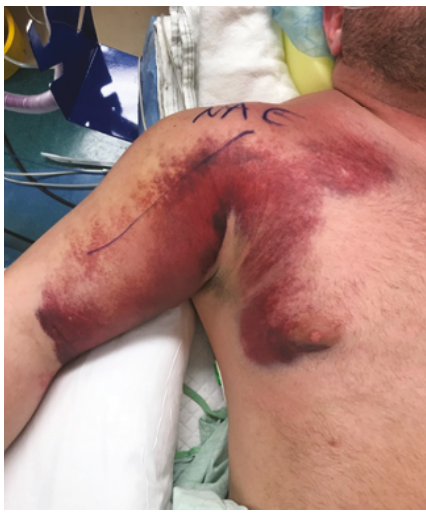
Figure 1: Deformity of anterior axillary fold.